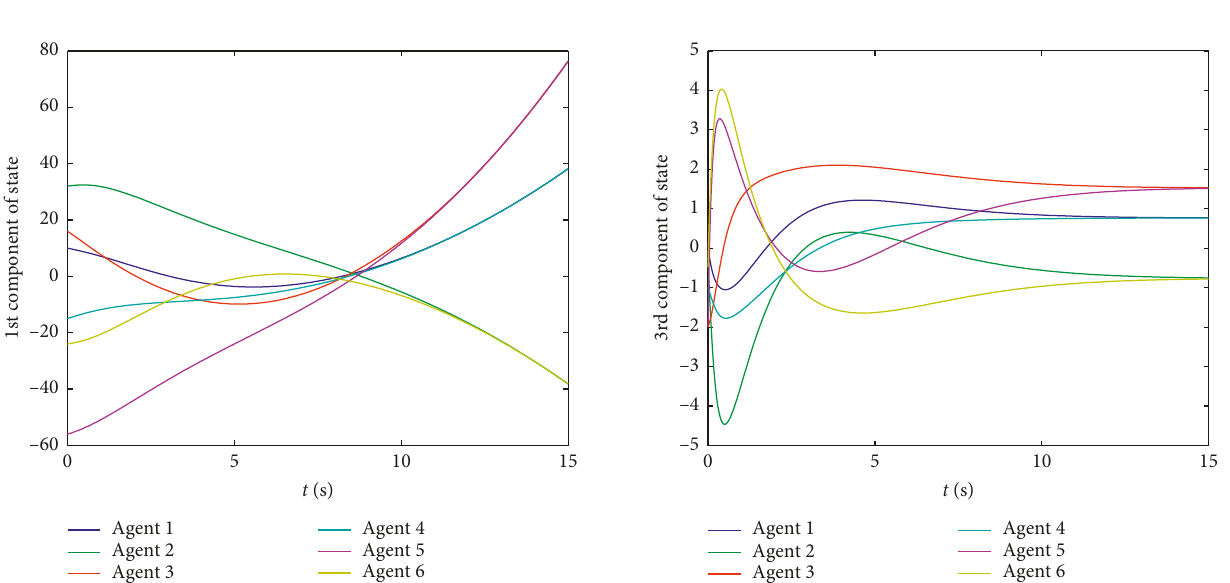
Figure 8: Trajectories of x